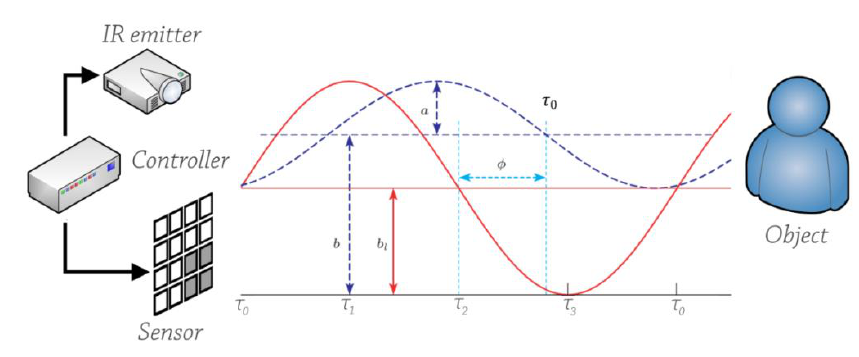
Figure 2. Time-of-flight working principle.